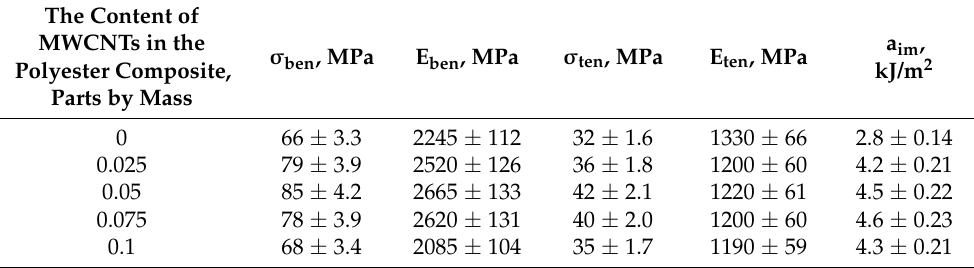
Table 1. Selection of the optimal amount of MWCNTs in a polyester